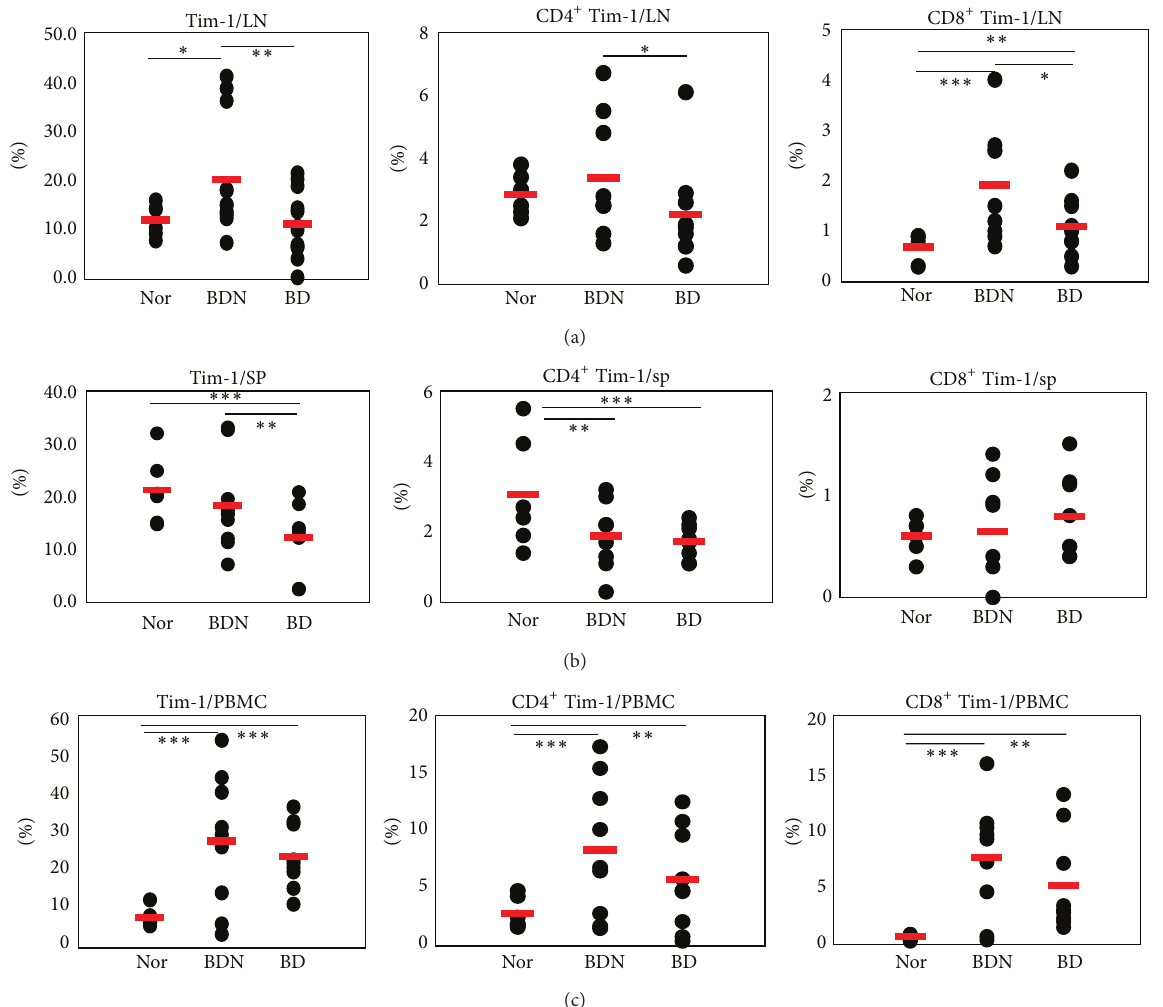
Figure 1: The frequencies of Tim-1 + cell phenotypes in normal healthy, Behc¸et’s disease (BD) normal (BDN), and BD mice. The frequencies of Tim-1 + , CD4 + Tim-1 + and CD8 + Tim-1 + , cells in BD mice were compared to Nor and BDN mice by FACS analysis in (a) lymph nodes, (b) spleen, and (c) peripheral blood mononuclear cells (PBMCs) ( 𝑛 = 6 –12) ( ∗ 𝑃 < 0.1 , ∗∗ 𝑃 < 0.05 , ∗∗∗ 𝑃 < 0.01 ). Nor: normal healthy mice, BDN: BD normal